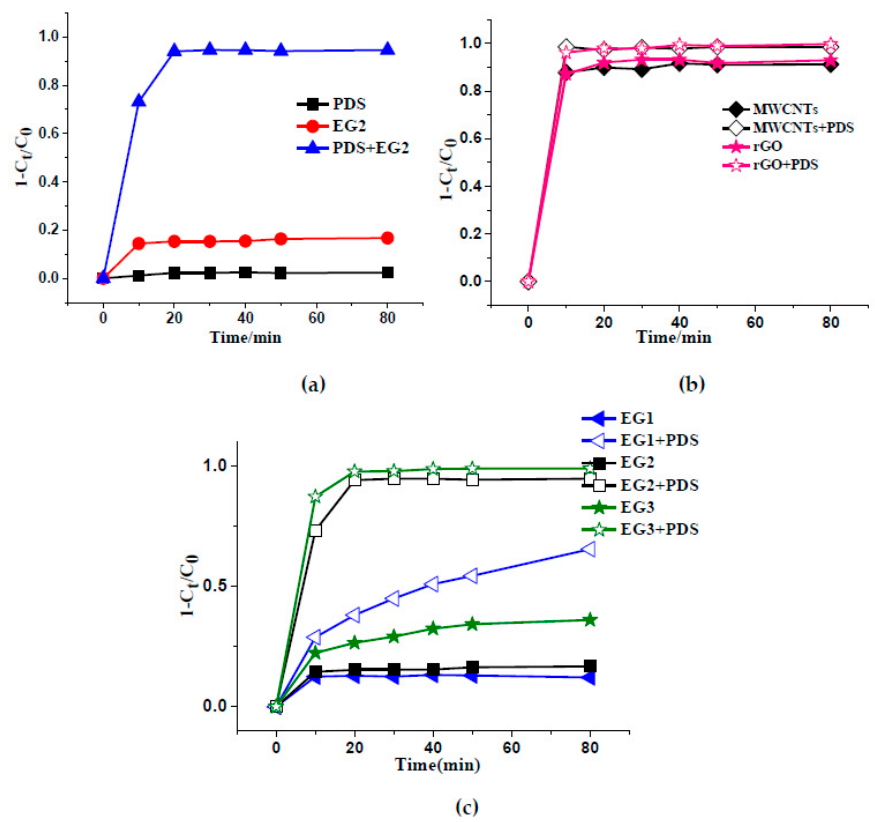
Figure 3. ( a ) Time-dependent degradation of Acid Red 97 (AR97) by EG2/PDS system, ( b ) Time-dependent degradation of AR97 by other catalyst/PDS systems, ( c ) The removal of AR97 under different EG. [AR97] 0 = 50 mg × L − 1 ; [PDS] 0 = 2 mmol × L − 1 ; pH = 6.9; [EG1] 0 = 1 g × L − 1 ; [EG2] 0 = 1 g × L − 1 ; [EG3] 0 = 1 g × L − 1 ; [CNT] 0 = 1 g × L − 1 ; [rGO] 0 = 1 g × L − 1.